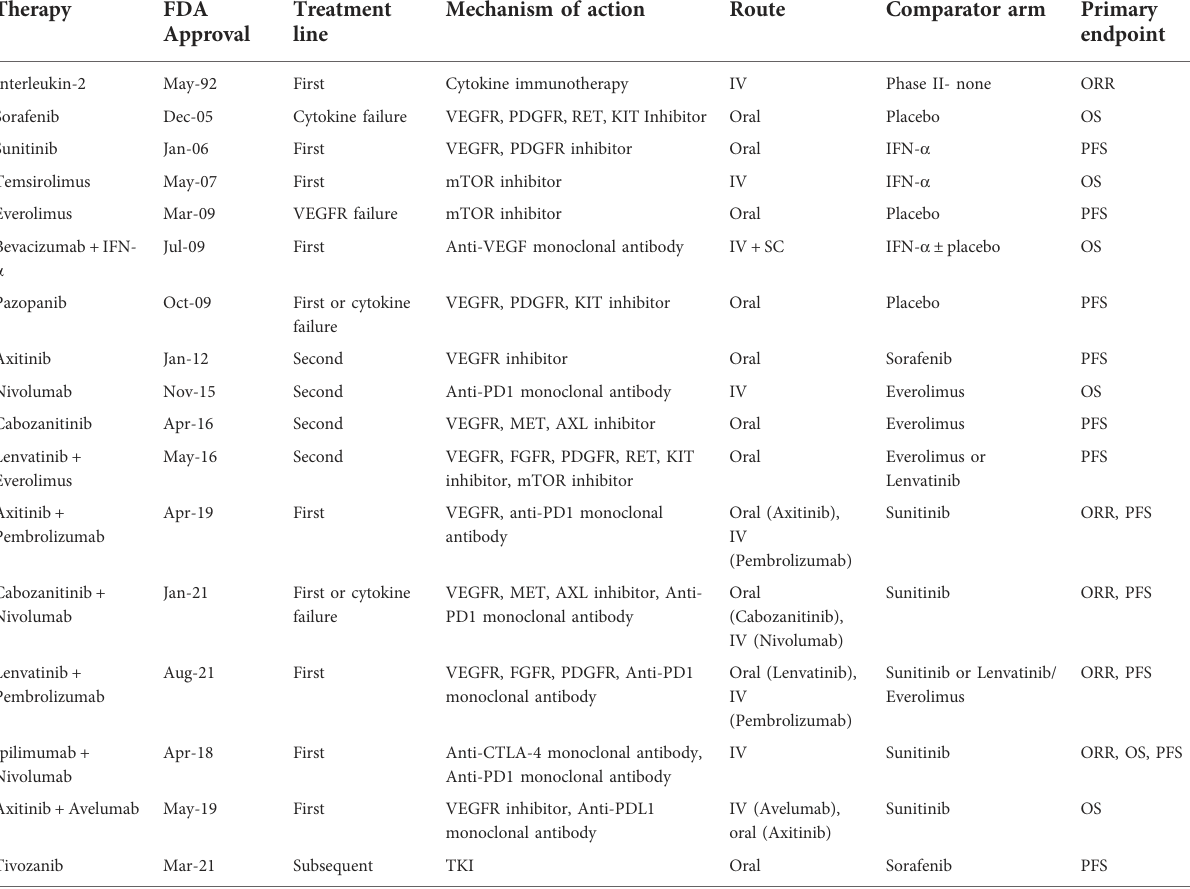
TABLE 1 FDA-Approved systemic therapies for the treatment of metastatic renal cell carcinoma.